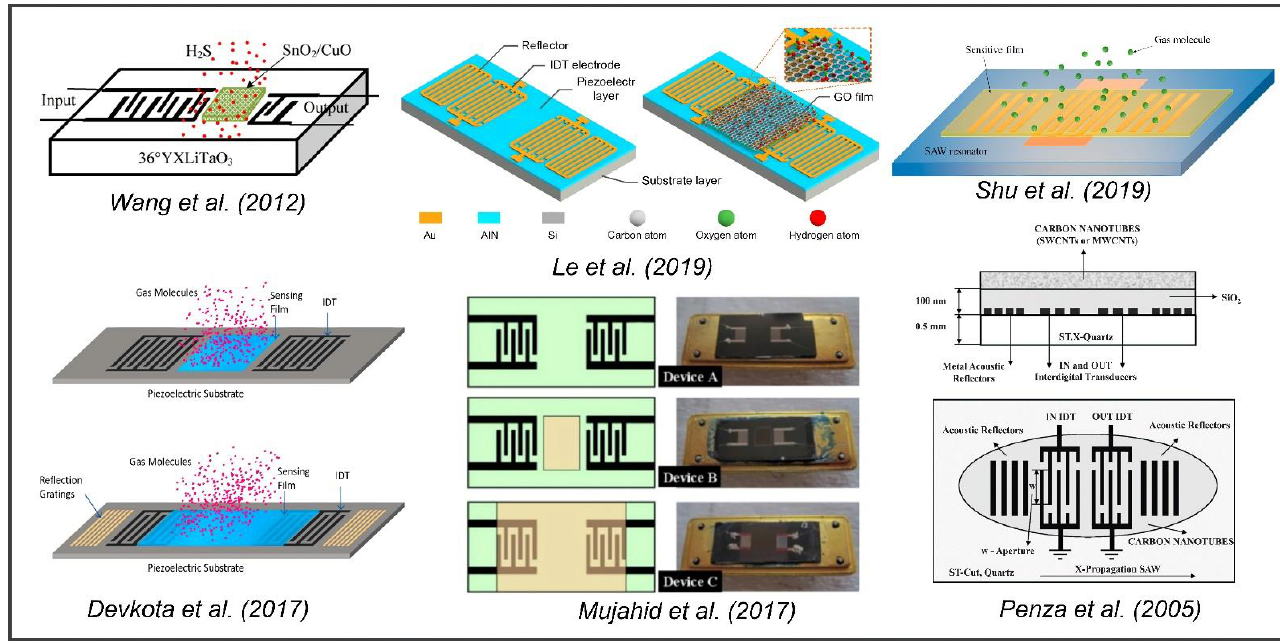
Figure 21. Different applications and methods of chemical and gas sensing using SAW devices [84,179–183].